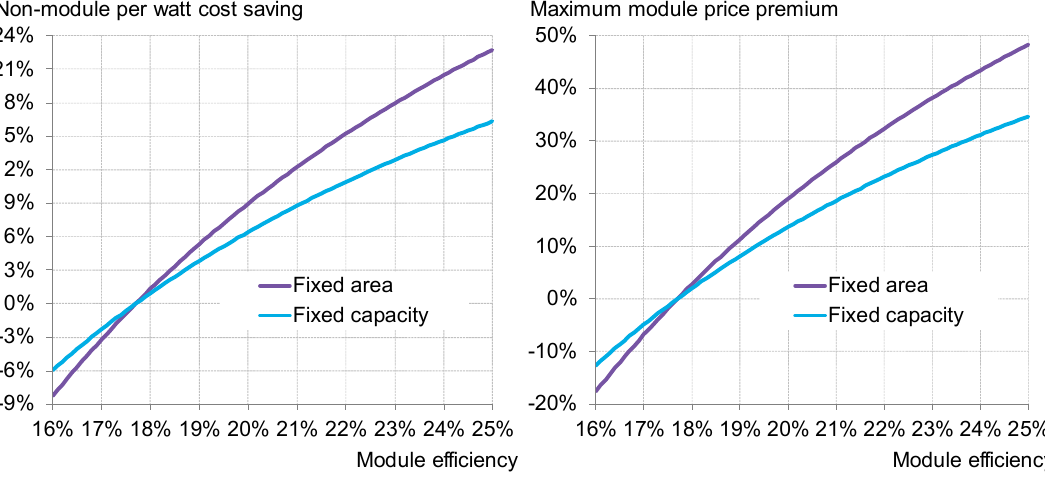
Figure 5. Impact of module efficiency on PV system cost and module price premium. Note: In the left-hand chart, the relative change in terms of percentage refers to the non-module unit cost of the benchmark case as shown in Figure 4. In the right-hand chart, the reference is the module unit cost of the benchmark case in Figure 4.